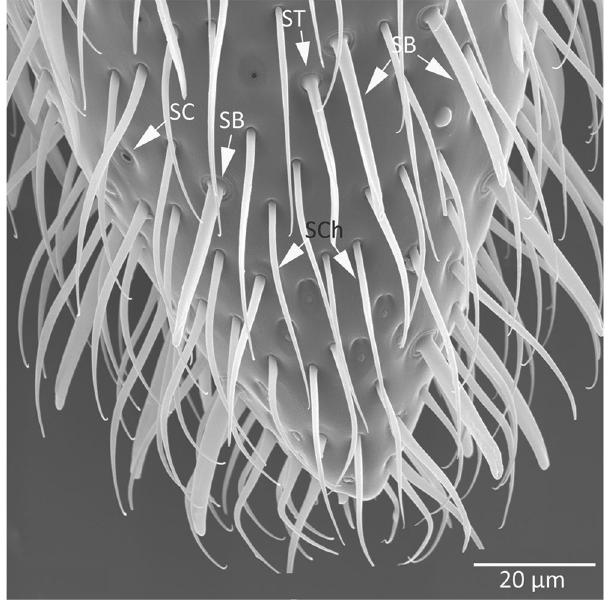
Figure 1. Antennal olfactory sensilla of a female Harpegnathos saltator . Scanning electron micrograph showing an overview of a distal segment covered with sensilla basiconica (SB), trichodea (ST), coeloconica (SC), and chaetica (SCh). The latter were not included in the counts as they are not involved in